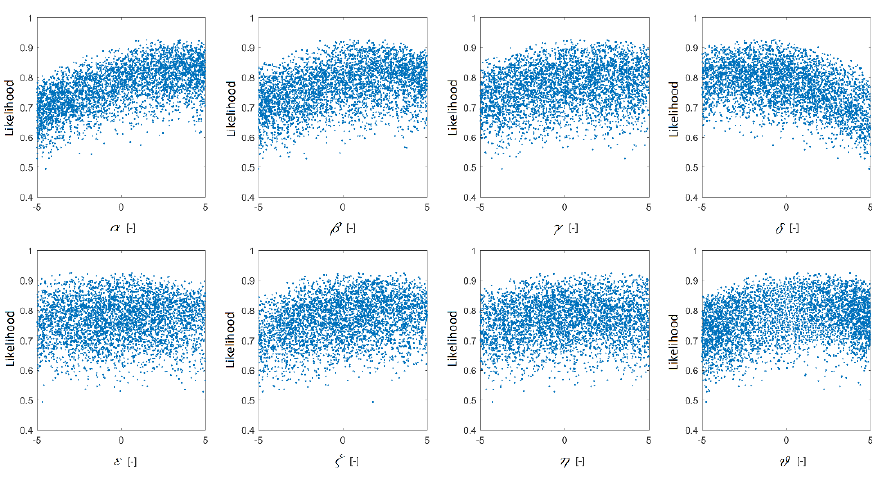
Figure 5. Scatterplots of the likelihood function for NDWI m parameters.